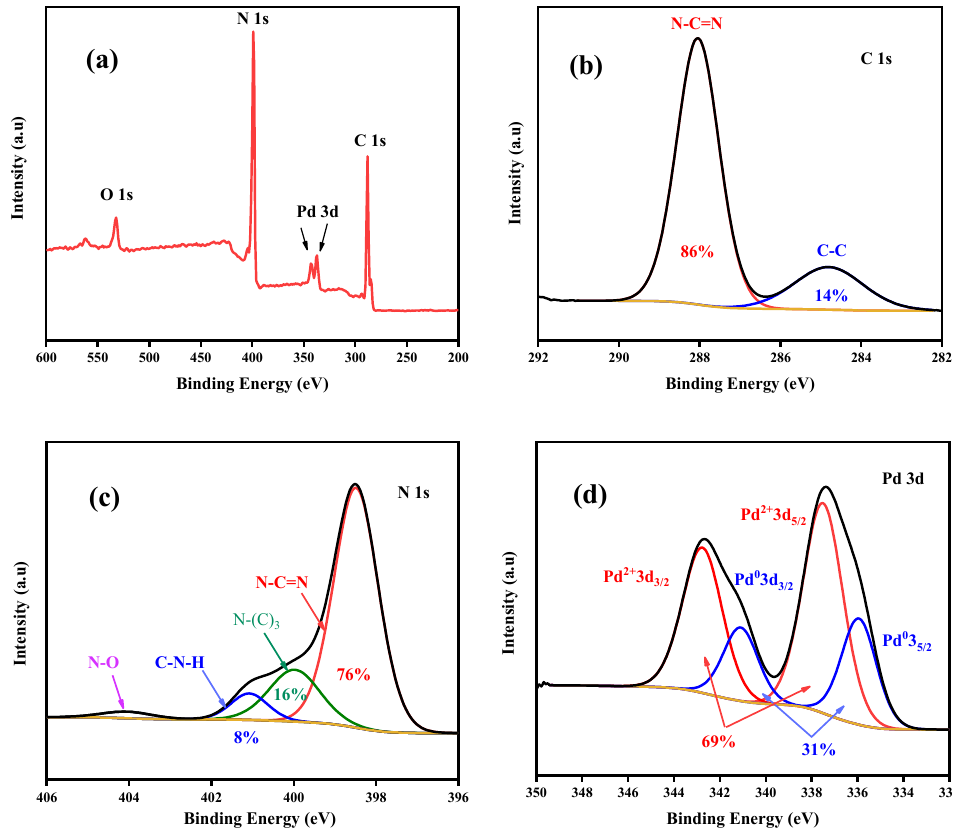
Figure 3. XPS spectra of 1.1 wt% Pd(OH) 2 /g-C 3 N 4 : ( a ) the survey spectrum; ( b ) the core-level spectrum of C1s; ( c ) the core-level spectrum of N 1s; ( d ) the core-level spectrum of Pd 3d 5/2 and 3d 3/2 doublet region.